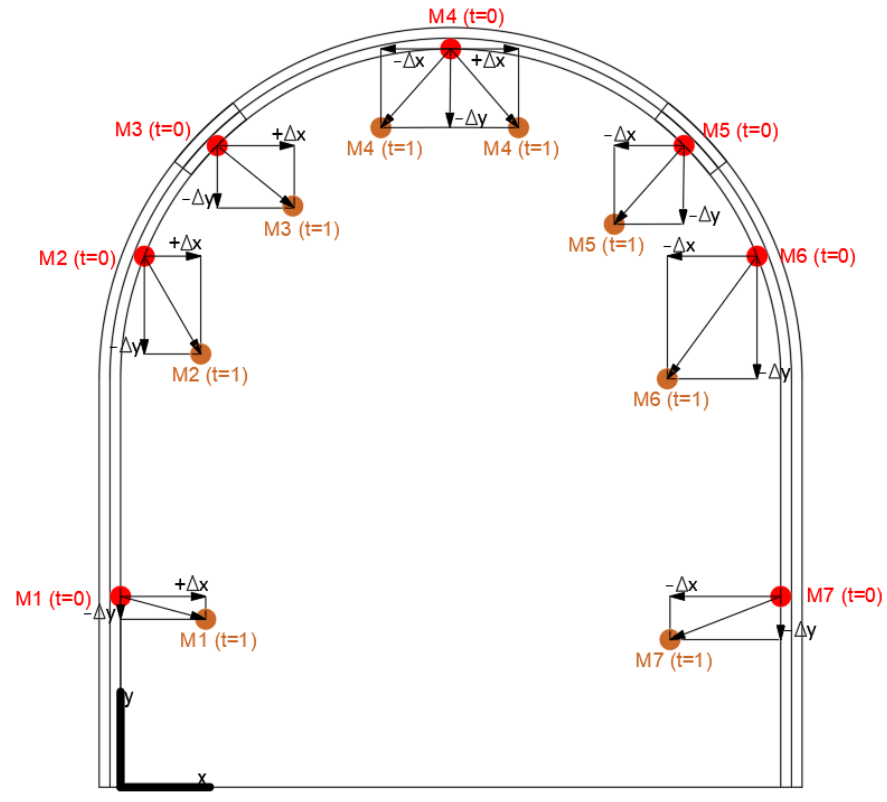
Figure 1. Positions of the markers (t = 0) and their displacements (t = 1). As seen from Figure 1, markers 1, 2, and 3 can change their positions with coordinates along y -axis with negative sign ( −Δ y ) and along the x -axis with positive sign (+ Δ x ). Marker 4 will change its coordinates in time by y -axis in negative sign ( −Δ y ), and changes along the x -axis are expected to occur in both negative and positive directions ( −Δ x and + Δ x ). Markers 5, 6, and 7 will have negative signs for changes both along the y -axis ( −Δ y ) and x - axis ( −Δ x ). Positions of the markers in time are described by the equation 𝑀 (cid:3036) (𝑡 = 0) = (cid:4668)𝑥 (cid:3036)(cid:3042) ; 𝑦 (cid:3036)(cid:3042) (cid:4669), ∀𝑖 ∈ (cid:4670)1, 𝑁(cid:4671) 𝑀 (cid:3036) (𝑡 = 1) = (cid:4668)𝑥 (cid:3036)(cid:3042) ± ∆𝑥(𝑡 = 1); 𝑦 (cid:3036)(cid:3042) − ∆𝑦(𝑡 = 1)(cid:4669), ∀𝑖 ∈ (cid:4670)1, 𝑁(cid:4671) ⋮ 𝑀 (cid:3036) (𝑡) = (cid:4668)𝑥 (cid:3036) (𝑡 − 1) ± ∆𝑥(𝑡); 𝑦 (cid:3036) (𝑡 − 1) − ∆𝑦(𝑡)(cid:4669), ∀𝑖 ∈ (cid:4670)1, 𝑁(cid:4671) (1) where N represents the total number of markers. The changes in the shape of steel arch support for a de fi ned time interval (0, t ) can be displayed via the marker union as follows: (cid:4651) 𝑀 (cid:3036)(cid:3015) (cid:3036)(cid:2880)(cid:2869) (𝑡), ∀𝑡 ∈ (cid:4670)0, 𝑇(cid:4671)